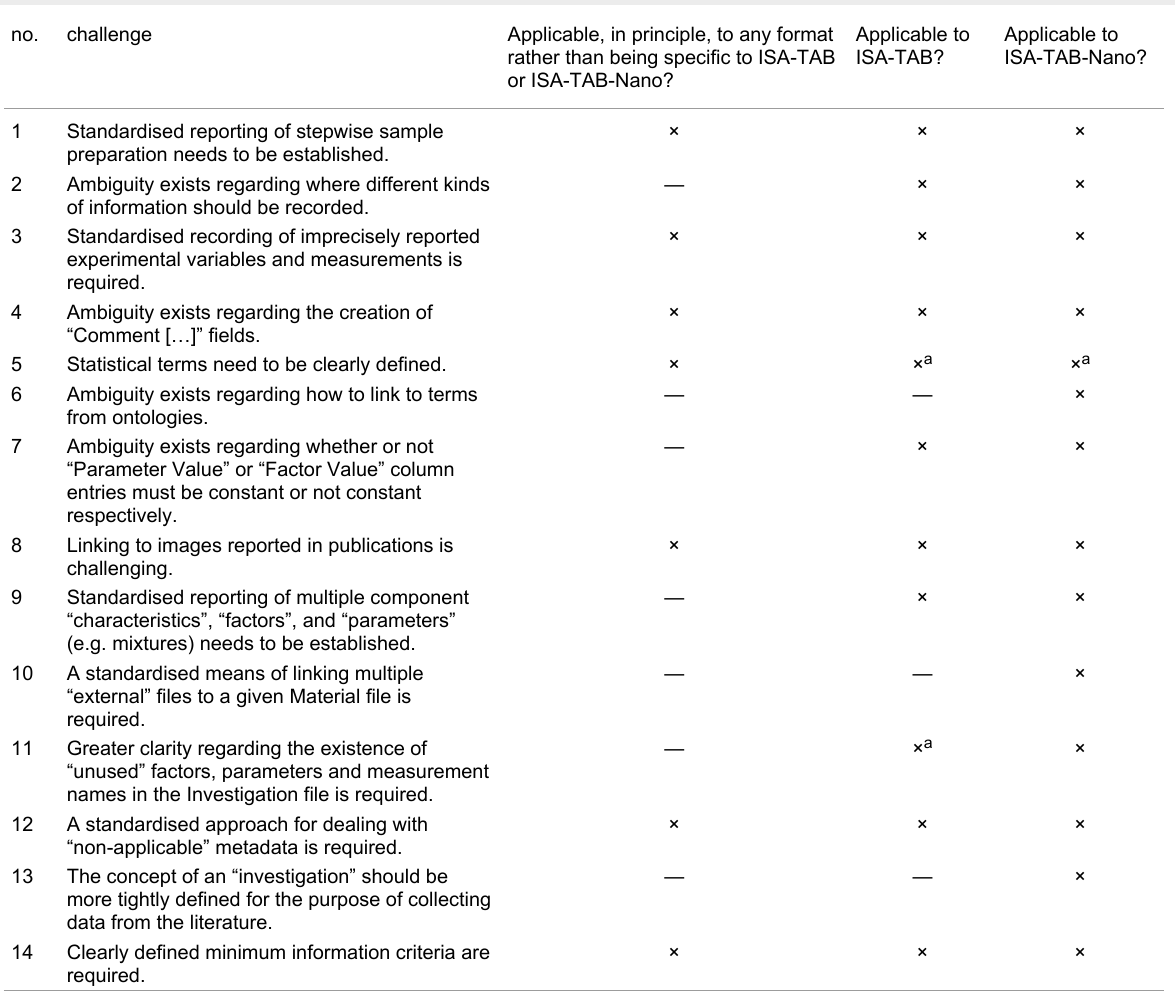
Table 1: Summary of challenges with the generic ISA-TAB-Nano specification which were addressed in the current work. no.